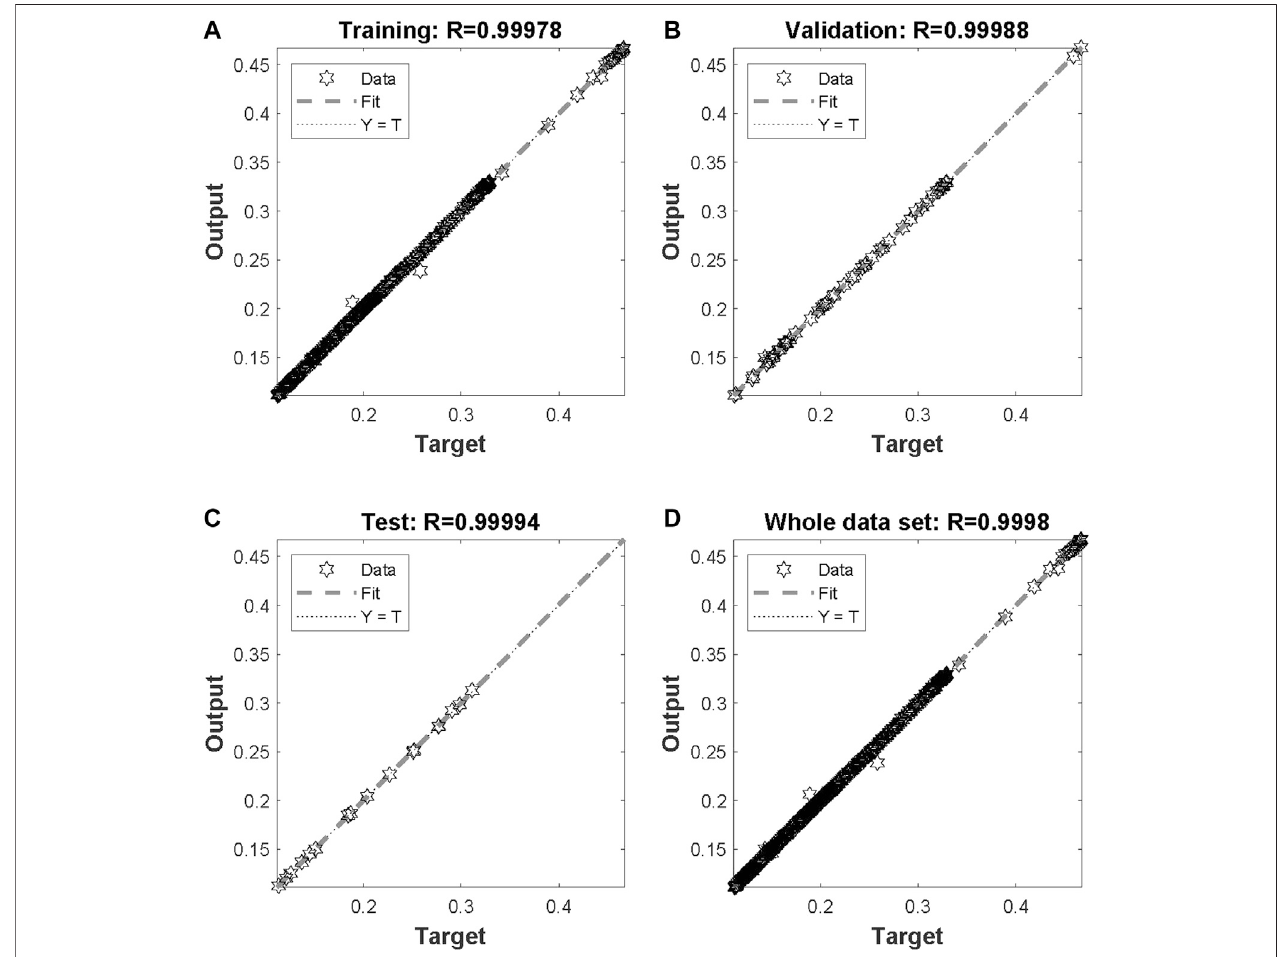
FIGURE 4 | Regression plots showing network results compared with targets for (A) training, (B) validation, (C) test and (D) whole data set.